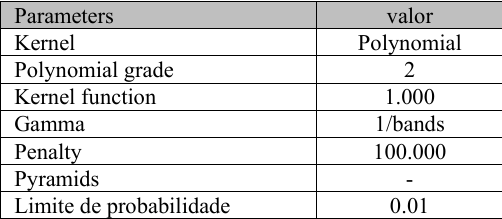
Table 1 . SVM parameters obtained in Weka mining.